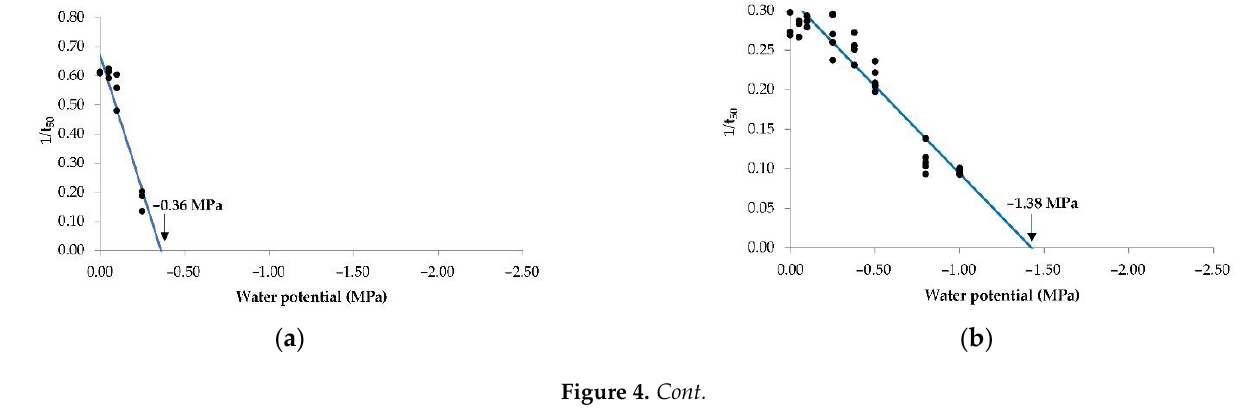
Table 2. Germination dynamics at different water potentials (MPa) at 22 ◦ C.